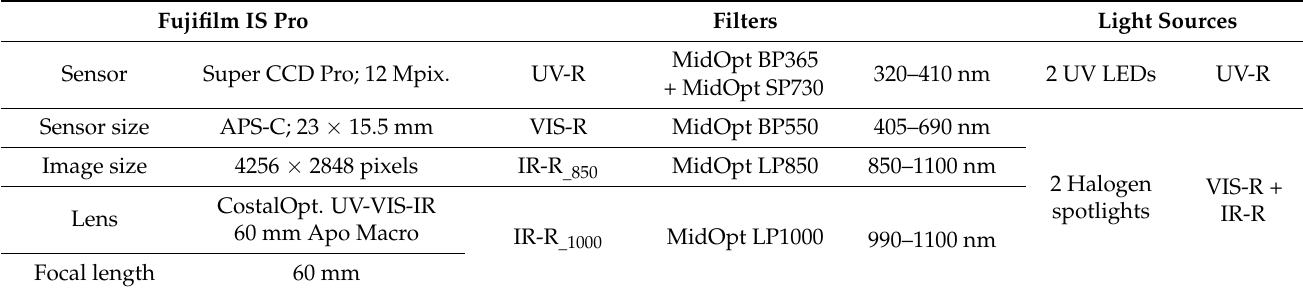
Table 2. Main specifications of the equipment used for MBI data acquisition.